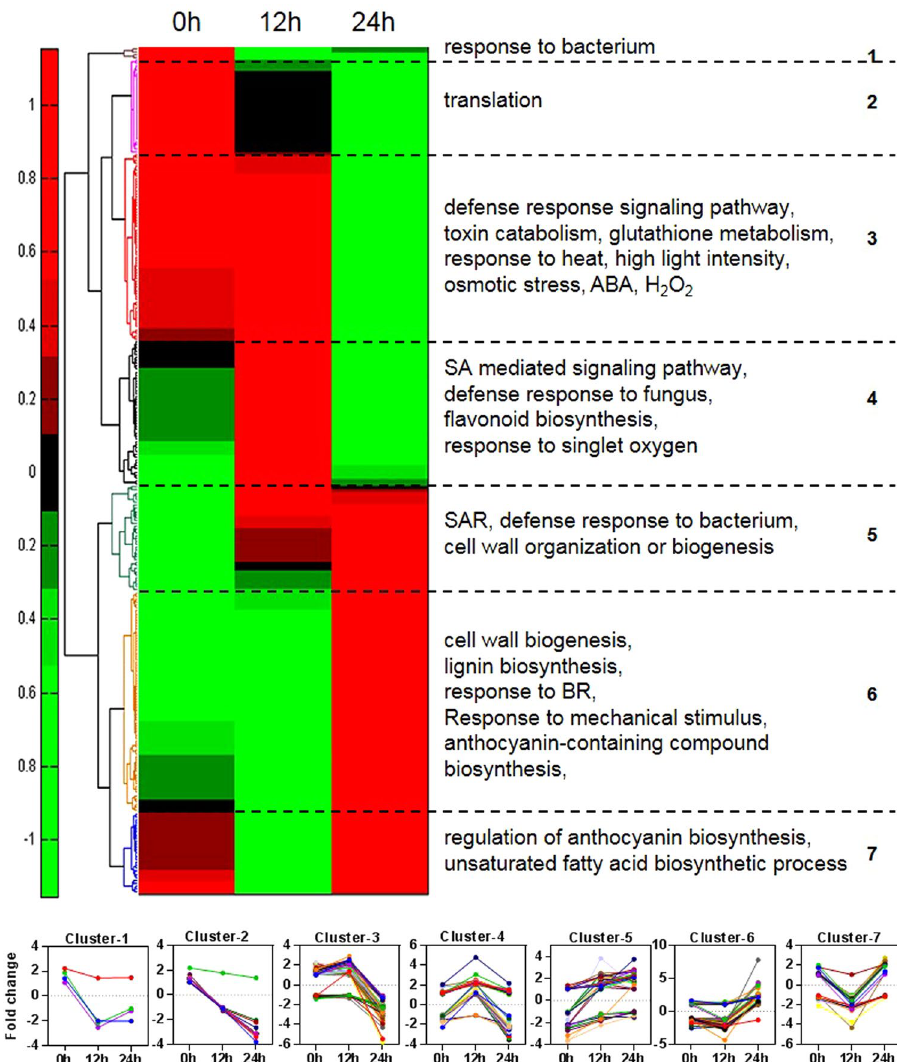
Figure 3. Hierarchical clustering of differentially expressed genes after infection with B . cinerea in A . thaliana exposed to 1000 Hz sound vibration. A total of 280 differentially expressed (2 fold as threshold) genes were classified in seven clusters (1 to 7) through hierarchical clustering with Z-score normalization. Red and green colors indicate up- and down- regulated genes, respectively. Enriched gene ontology of biological process ( P < 0.05) were mentioned in every cluster. Details of the genes and enrichment analysis of all GO classes are available in Supplementary Table S2. Line graphs at bottom indicate the fold change of the genes of each cluster. The time (0, 12, and 24 h) indicates h post inoculation